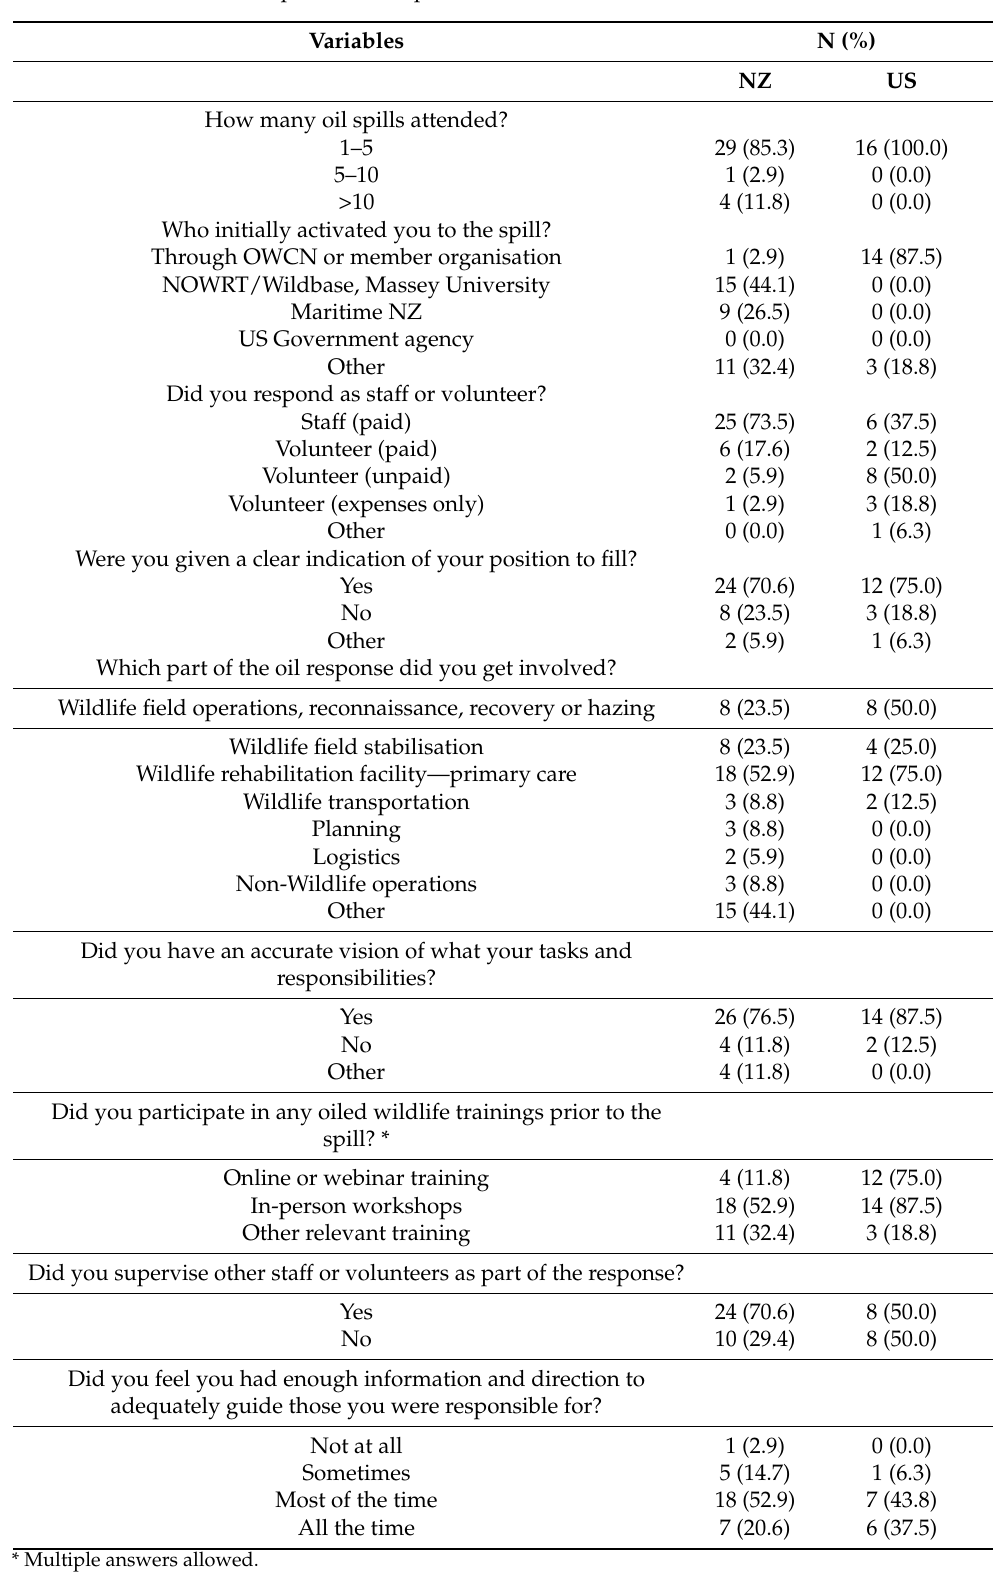
Table 2. Involvement with previous oil spill